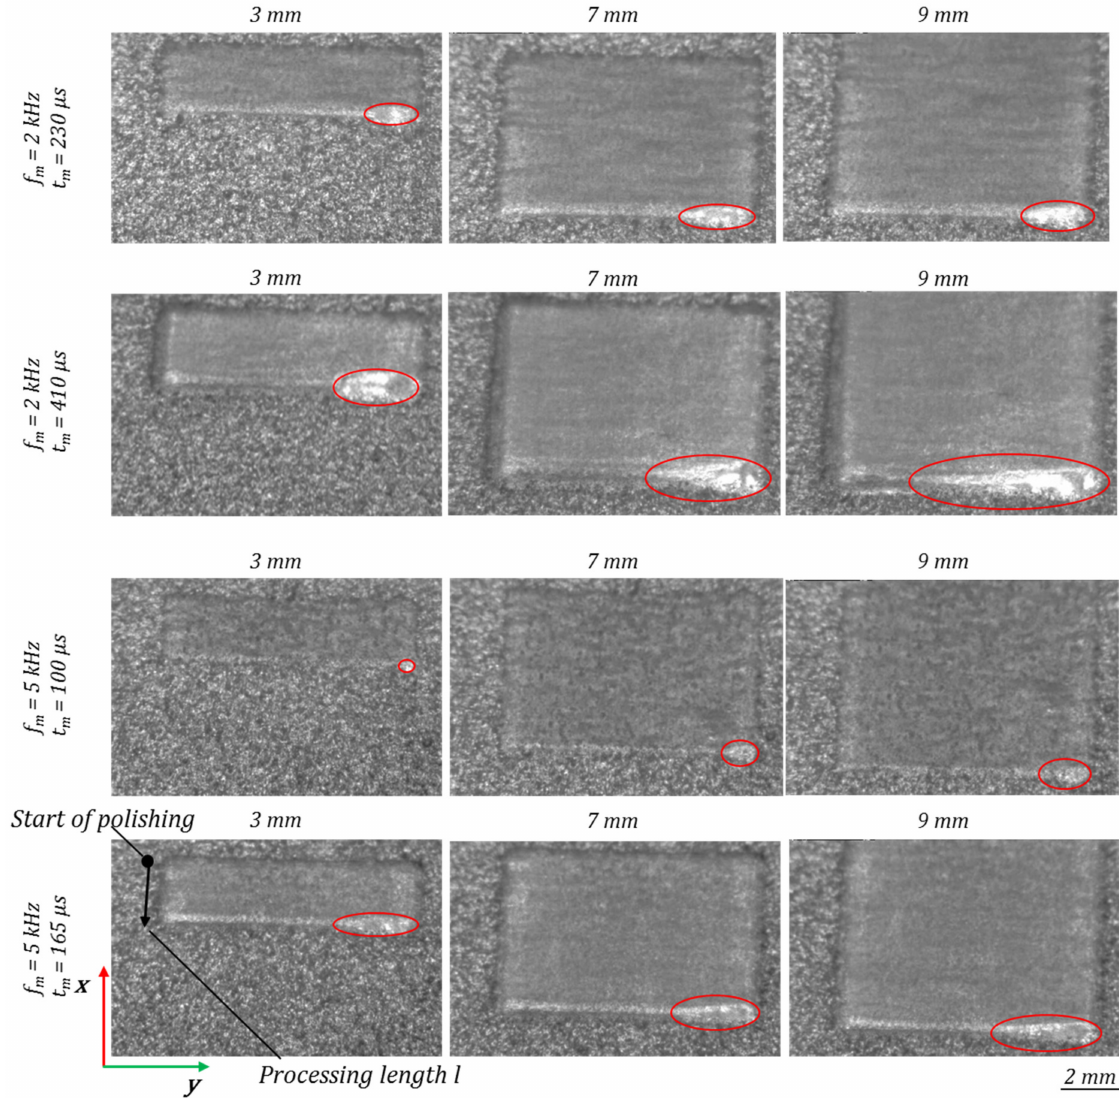
Figure 28. Melt pool dimensions at a processing length of 3 mm, 7 mm and 9 mm, depending on the modulation time t m and frequency f m , analysed by single frames from high-speed